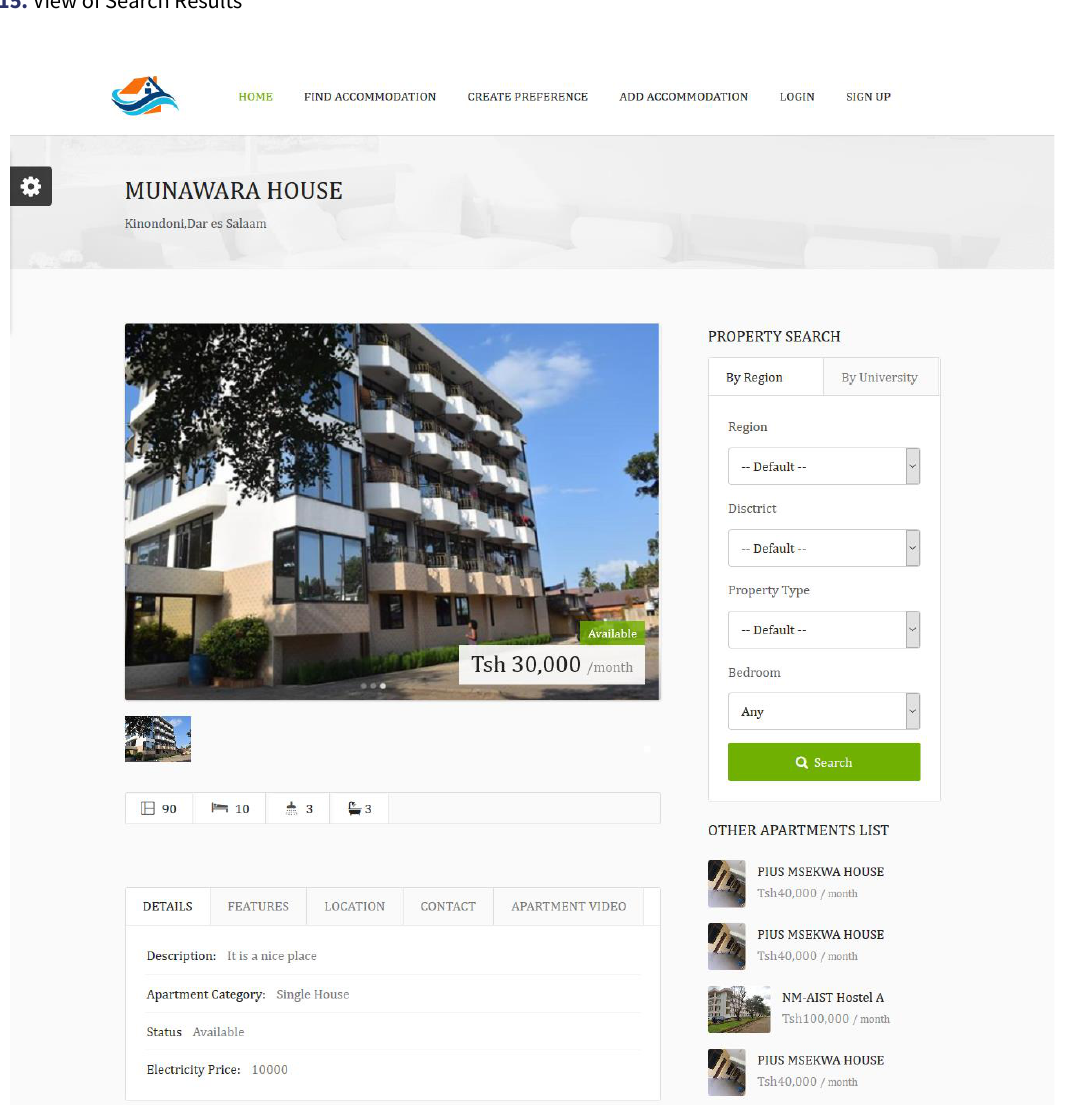
Figure 16. View of Accommodation